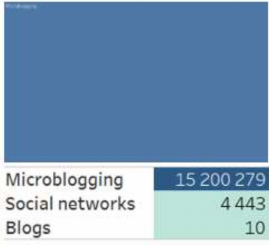
Figure 2. Digital platforms of Moscow actors.